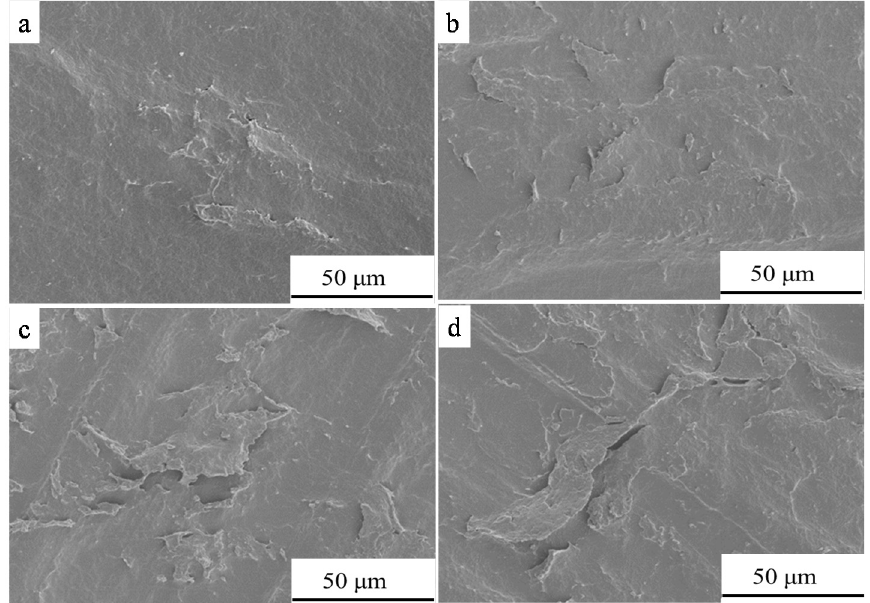
Figure 3. SEM images of surface morphology of the Go-TPU films prepared with loadings of